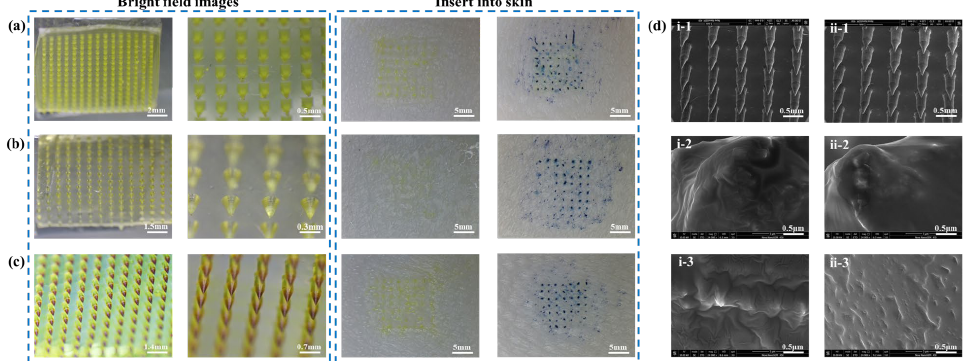
Figure 2. Bright field images of different shapes of CUR-MNs and skin insert rates under stereo microscope, ( a ) quadrangular cone, ( b ) cone, ( c ) bullet head; SEM images of ( d ) CUR-MNs ( i ) and CUR-MNs with HAase on the tip ( ii ).